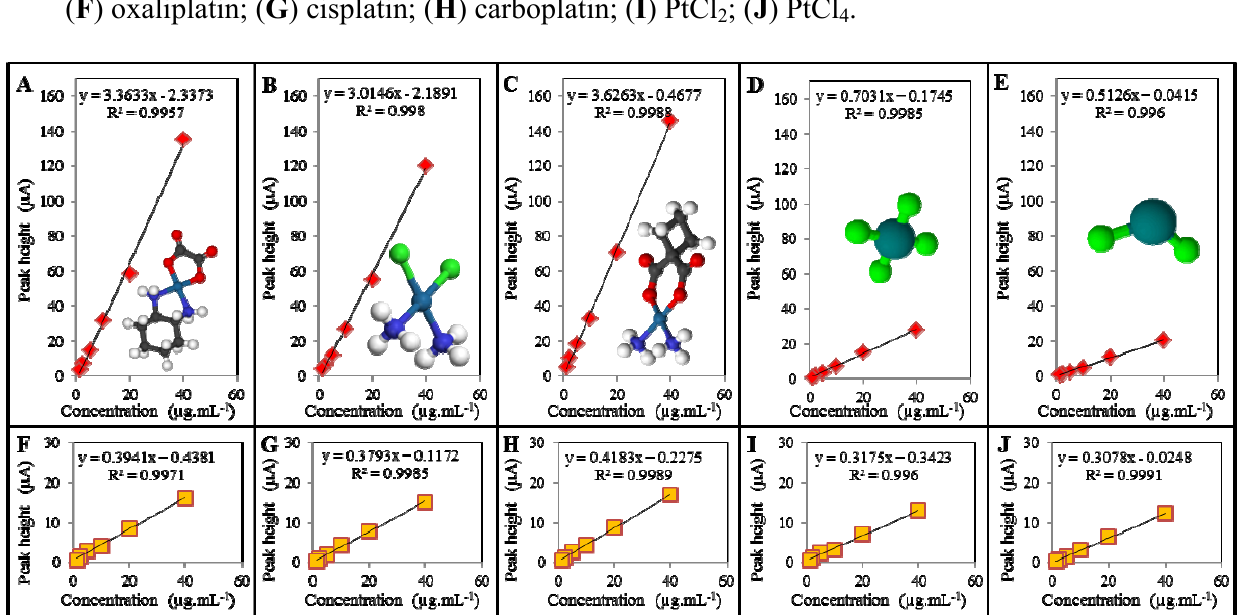
Figure 4. Calibration curves for individual platinum analytes measured at applied potential of 1200 mV, using Britton-Robinson buffer at pH 2: ( A ) oxaliplatin; ( B ) cisplatin; ( C ) carboplatin; ( D ) PtCl ; ( E ) PtCl and using Britton-Robinson buffer at pH 5: 2 4 ( F ) oxaliplatin; ( G ) cisplatin; ( H ) carboplatin; ( I ) PtCl ; ( J ) PtCl 2 4